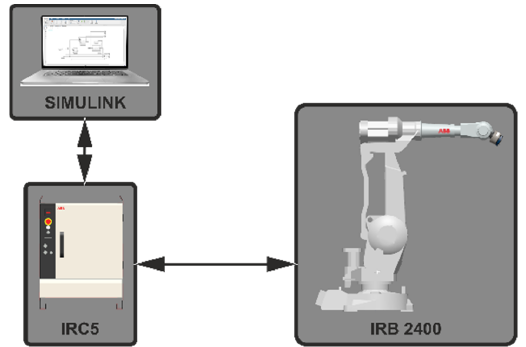
Figure 1. Diagram of the robotic station.